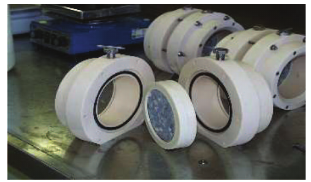
Fig. 13. Diffusion cells.